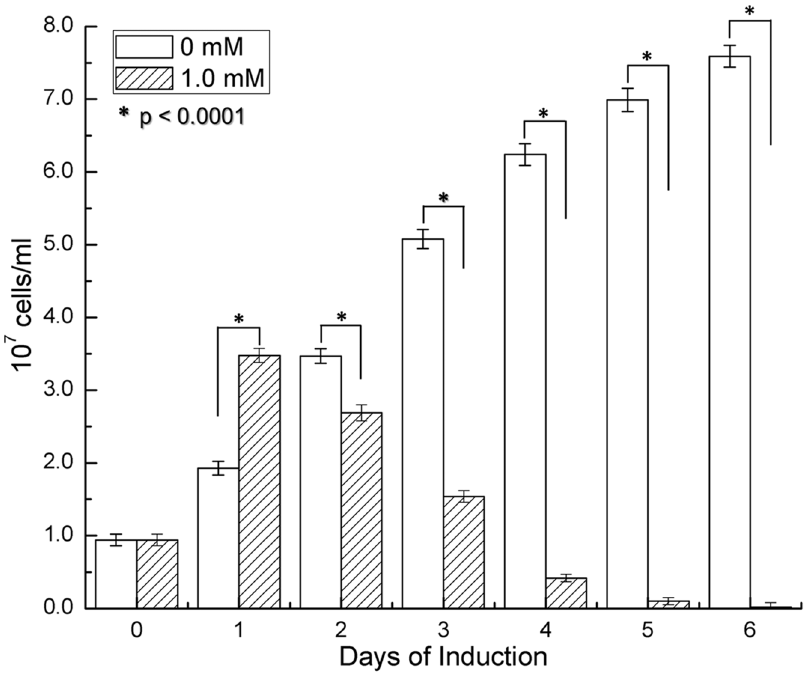
Figure 5. IPTG stimulates replication before causing death. Six 1.3-ml aliquots of D rpoS/rpoS in spirochetes at a density of 10 7 cells/ml were prepared. IPTG was added to 3 aliquots for a final concentration of 1.0 mM. All aliquots were incubated at 33 u C and bacterial numbers were counted daily for 6 days. Means and standard deviations presented here are calculated from triplicates.